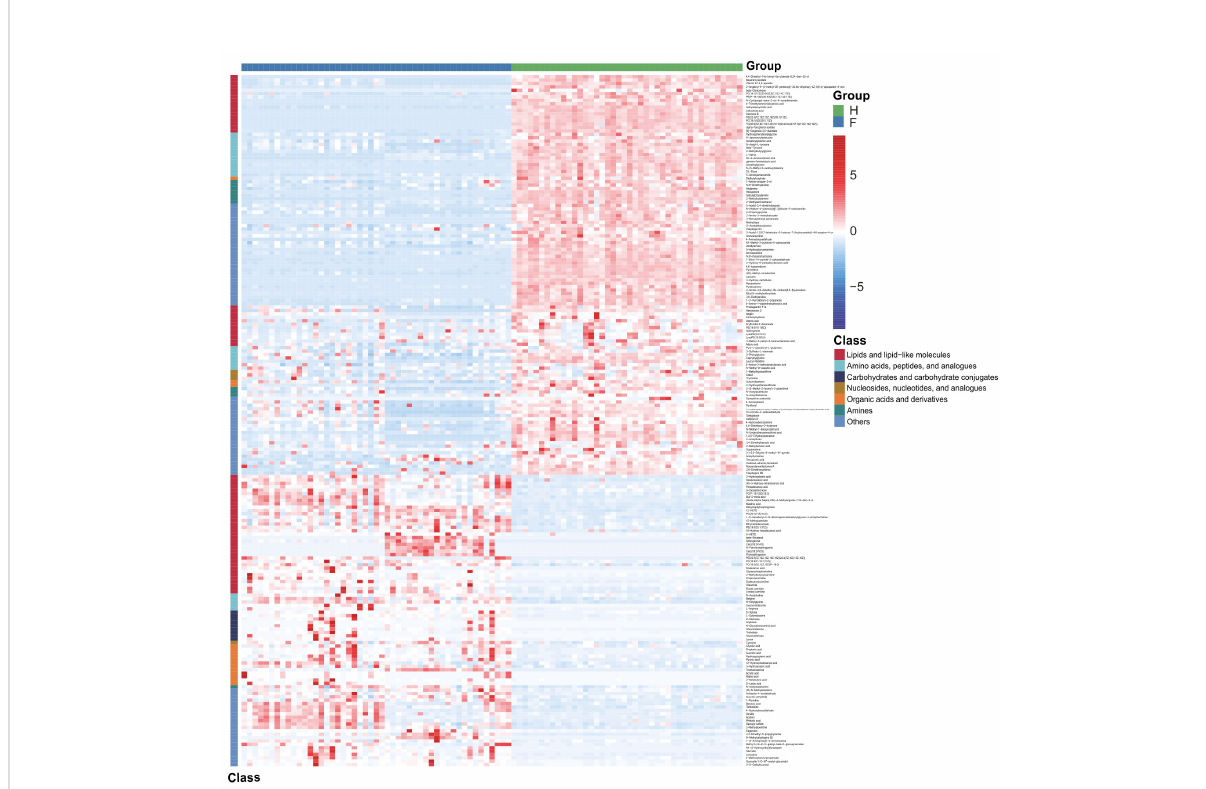
FIGURE 5 Hierarchical cluster analysis (HCA) was performed using quantitative values of differential metabolites in two groups. The horizontal coordinates represent the grouping, and the vertical coordinates represent the differential metabolites in the group. Red indicates high expression, whereas blue indicates low expression. F, IAV pneumonia group (blue); H, healthy group (green). IAV, in fl uenza A virus.